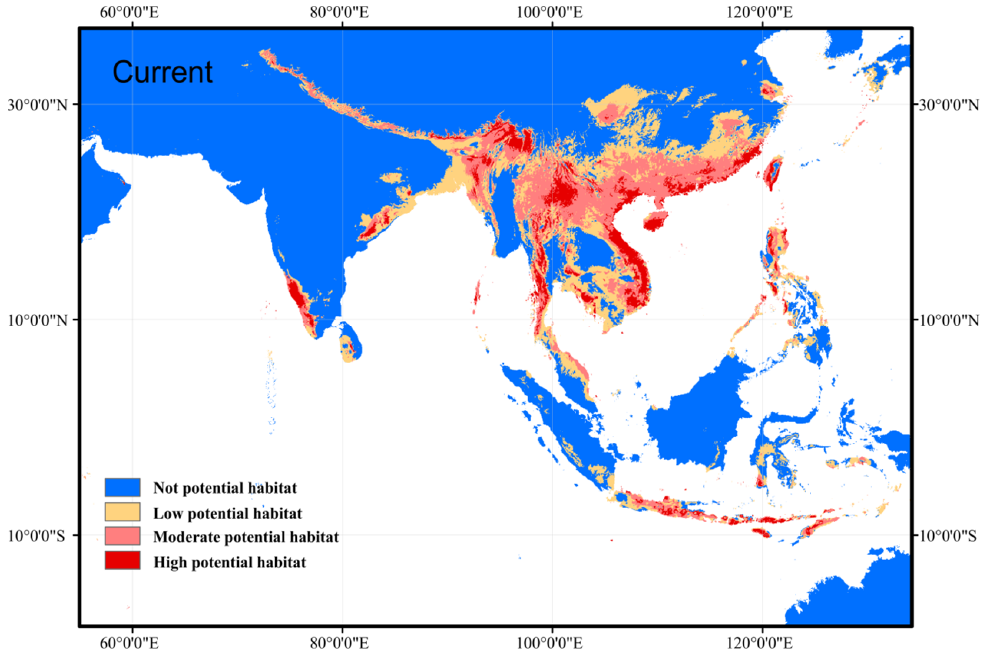
Table 2. Change of suitable habitat area and core distribution (km 2 ) of N. chinensis in current and future under four levels of greenhouse gas emission scenario.